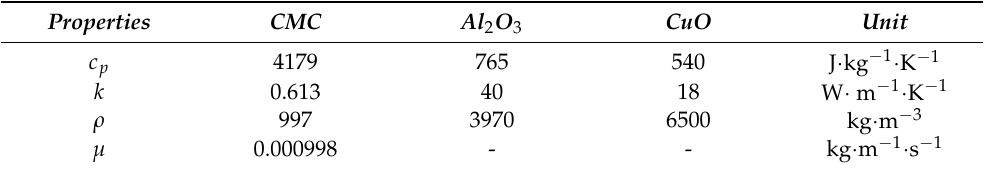
Table 3. The thermophysical features of nanoparticles and CMC (CMC/ Al 2 O 3 - CuO ) adopted from